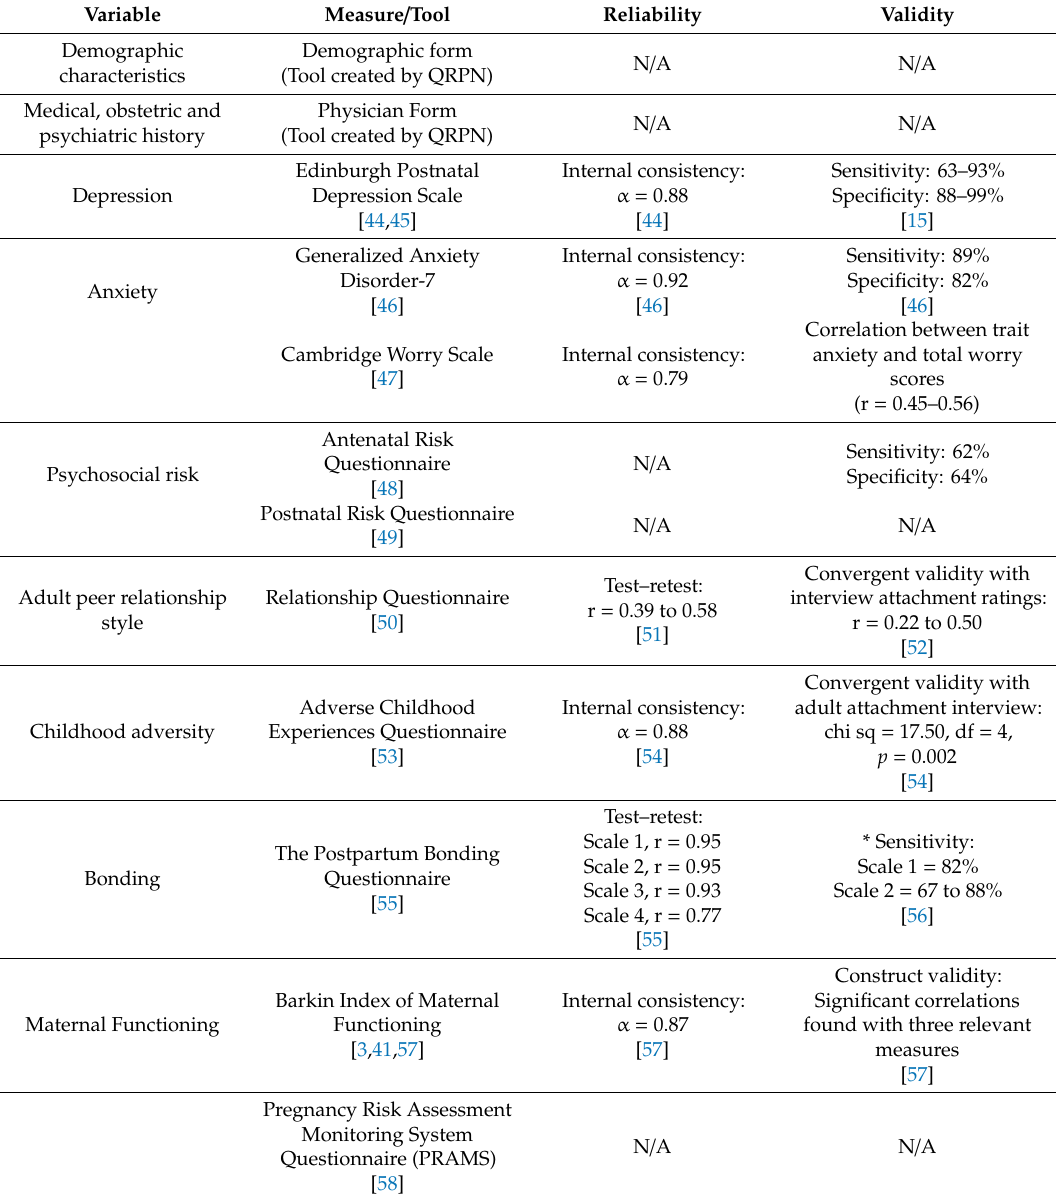
Table 1. Outcomes and